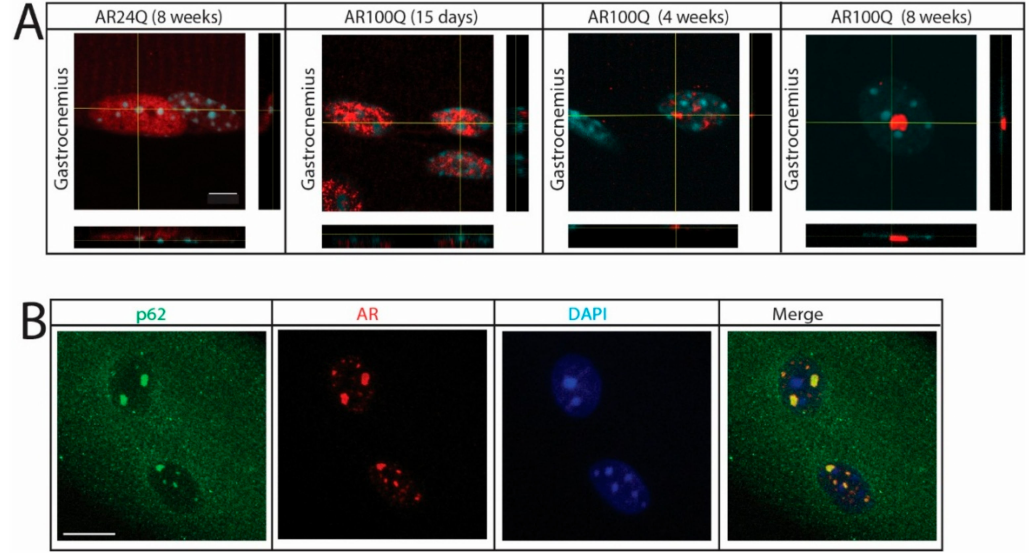
Figure 7. Nuclear enrichment and p62-positive pathology in SBMA muscle. ( A ) Confocal microscopy analysis of AR subcellular localization in intact myofibers from gastrocnemius muscle of AR24Q and AR100Q male mice. Bar, 5 micron. ( B ) Immunofluorescence analysis of AR and p62 subcellular localization in intact fibers from gastrocnemius muscle of 8-week-old AR100Q male mice. Bar, 10 micron. AR (red) and p62 (green) were detected with specific antibodies and nuclei with DAPI (blue). Shown are representative images of at least 3